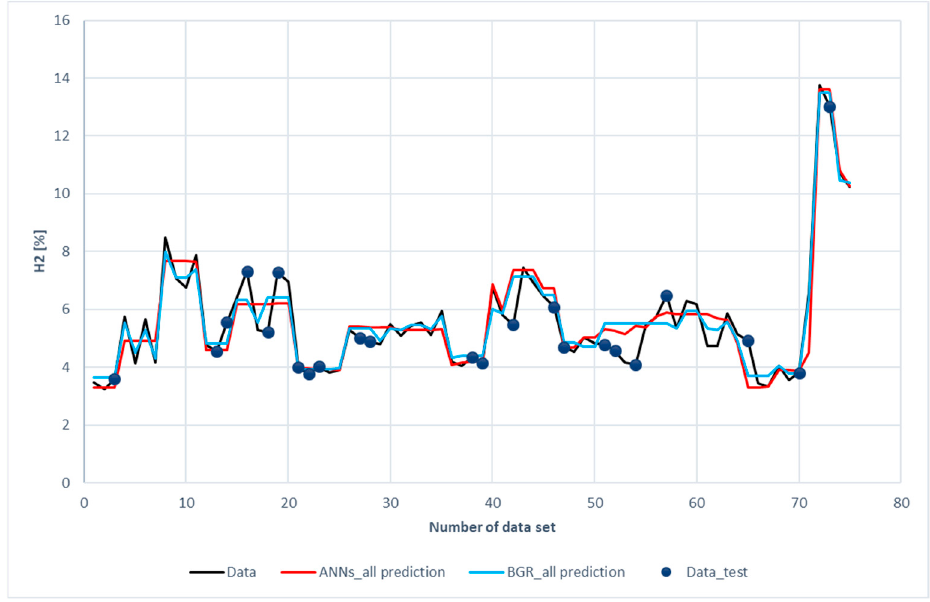
Figure 8. Comparison of H 2 compositions among the experimental data of the ANN and GBR models.